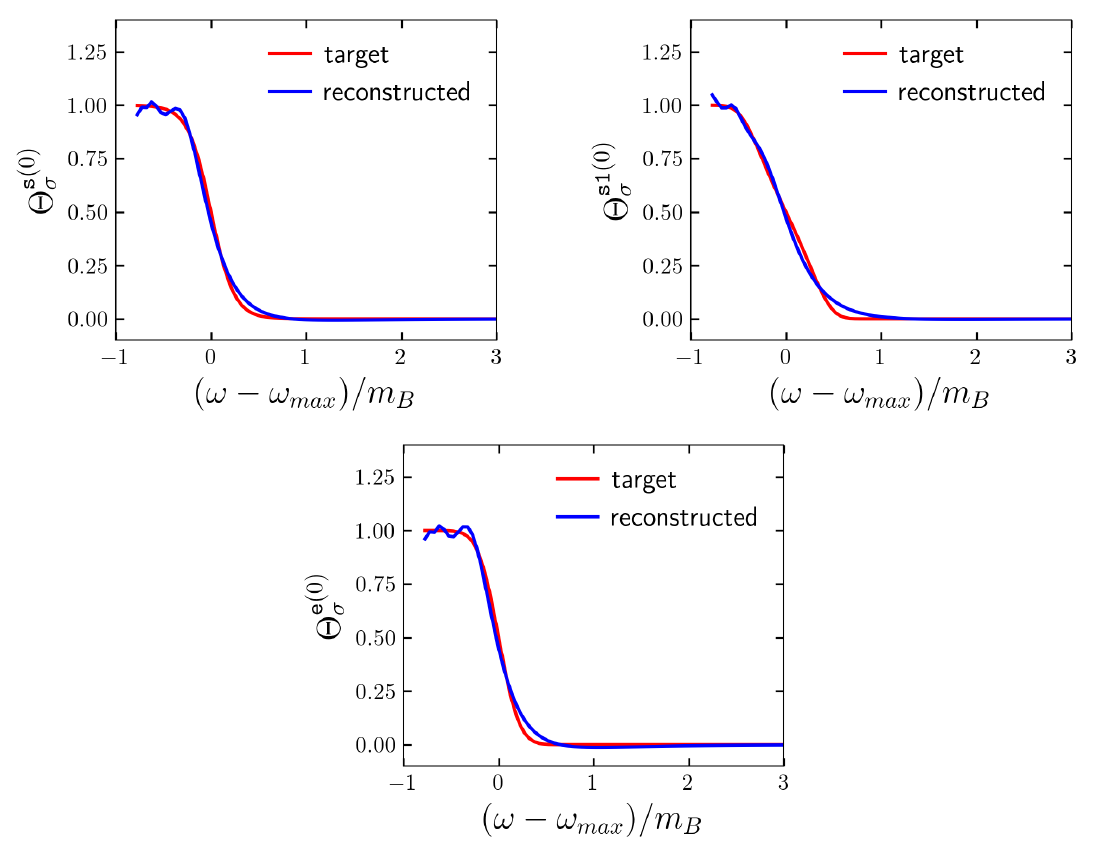
Figure 8 . Reconstruction of the kernels Θ (0) σ ( ω max − ω ) defined with the three smearing types s , s1 and e , see eq. (2.36), at λ = λ ? . The data correspond to | q | ’ 0 . 7 GeV and σ = 0 . 12 m B smallest value of the smearing parameter that we